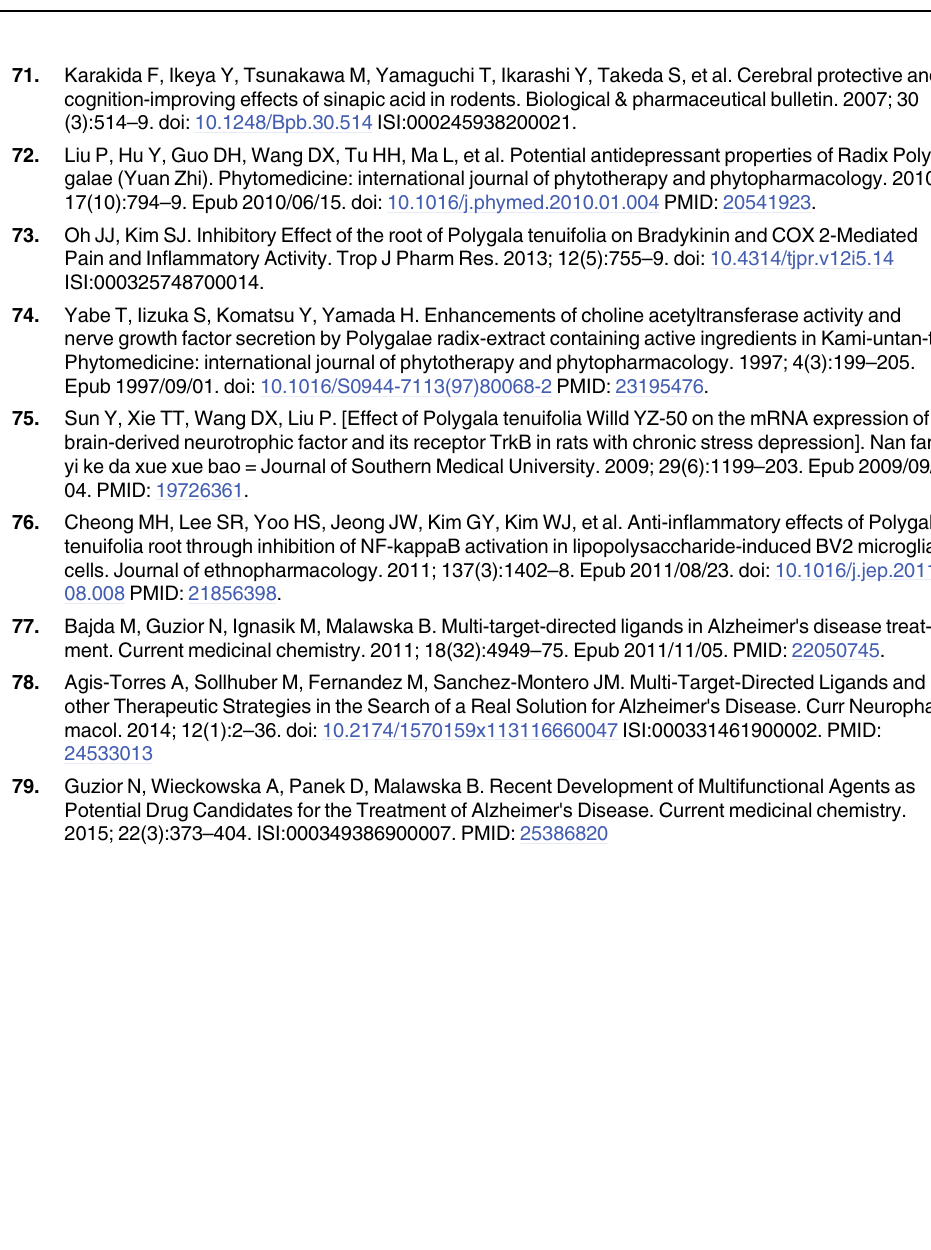
PLOS ONE | DOI:10.1371/journal.pone.0151147 March 8,